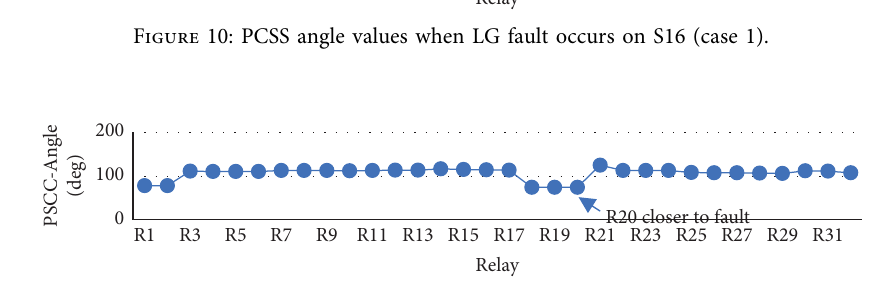
Figure 11: PCSS angle values when LLG fault occurs on S20 (case